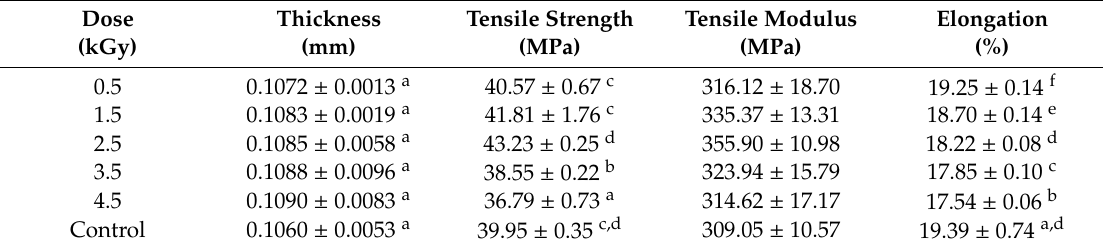
Table 2. The physical and mechanical properties of seaweed-neem composite films with di ff erent radiation